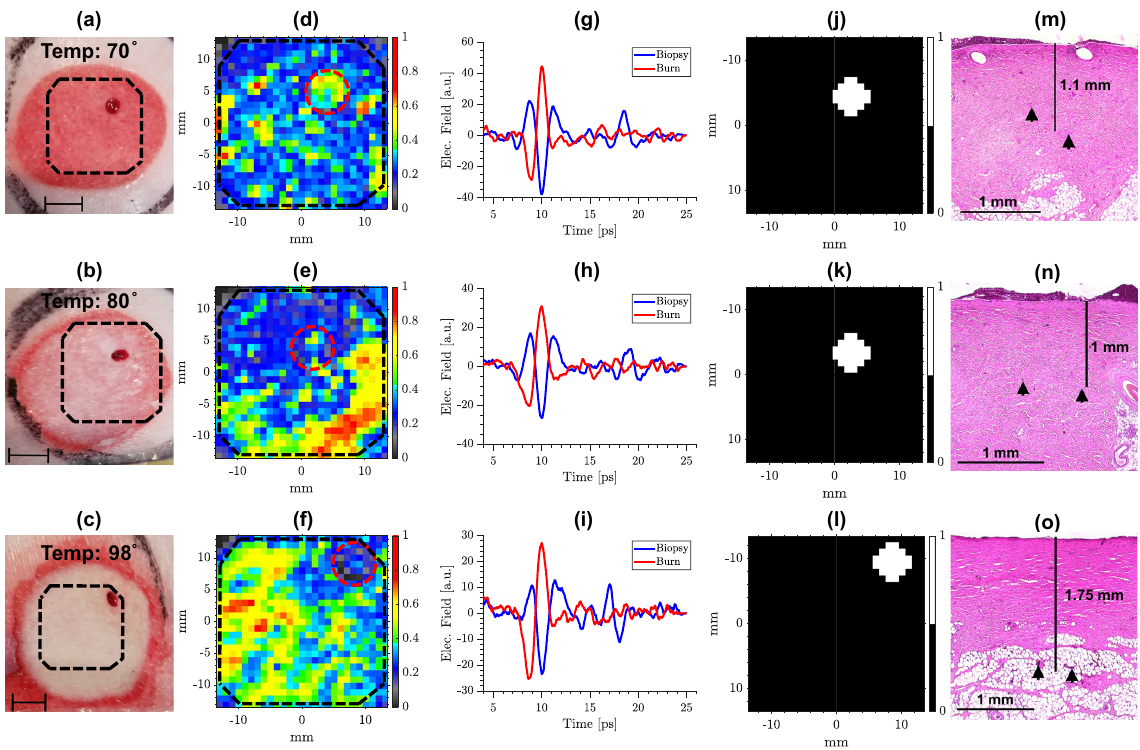
◦ ◦ ◦ , 80 , and 98 , respectively, the